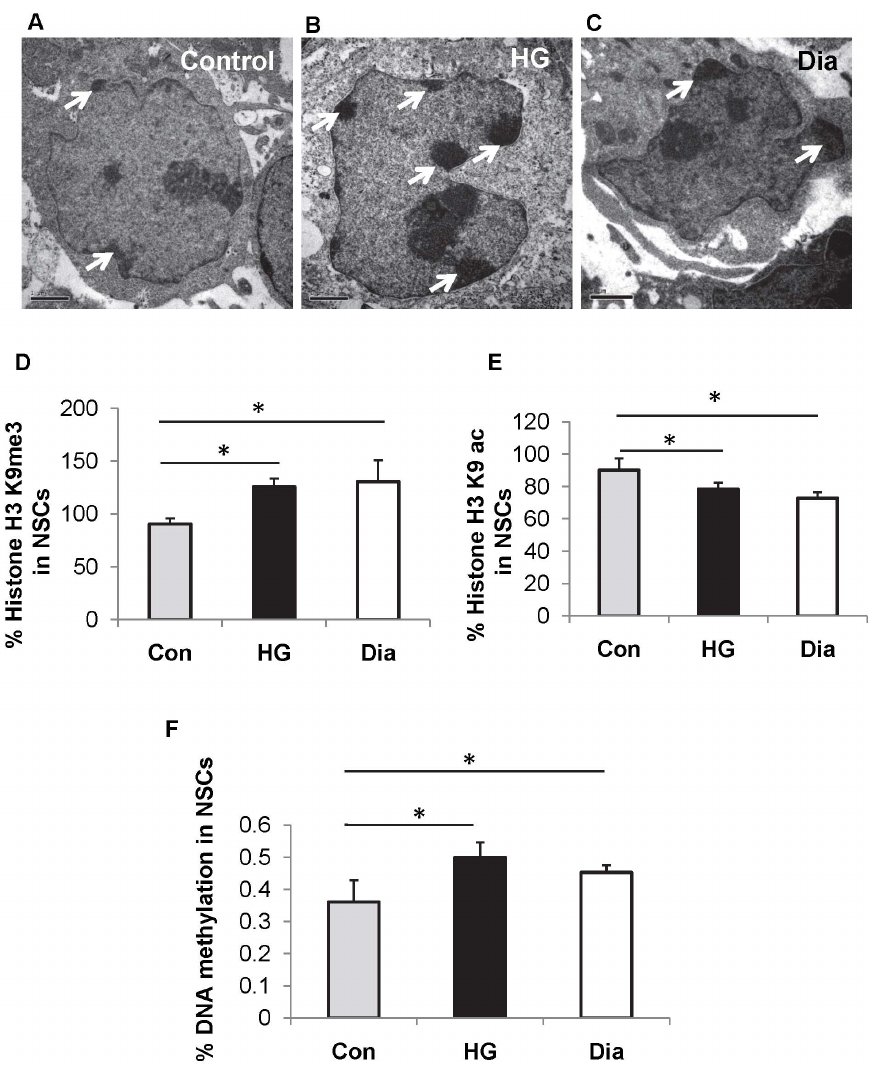
Figure 1. Hyperglycemia alters epigenetic mechanisms in NSCs . (A–C) Representative transmission electron microscopy images of NSCs from control (A), that exposed to high glucose (HG) in vitro (B) and from diabetic pregnancy (C). Increased heterochromatin structure at the nuclear periphery was observed in NSCs exposed to HG and that from diabetic pregnancy (white arrows). Bar represents 1 m m. (magnification: 13,500). (D, E) The percentage of H3K9me3 (D) was significantly increased in NSCs exposed to HG in vitro (black bars) and that from diabetic pregnancy (open bars) when compared to the control (grey bars) while the percentage of H3K9ac (E) was significantly decreased in NSCs exposed to HG in vitro (black bars) and that from diabetic pregnancy (open bars) when compared to the control (grey bars). (F) Increased percentage of DNA methylation was observed in NSCs exposed to HG in vitro (black bars) and that from diabetic pregnancy (open bars) when compared to the control (grey bars). The bar represents the mean 6 SD of at least 4 independent experiments, *p , 0.05